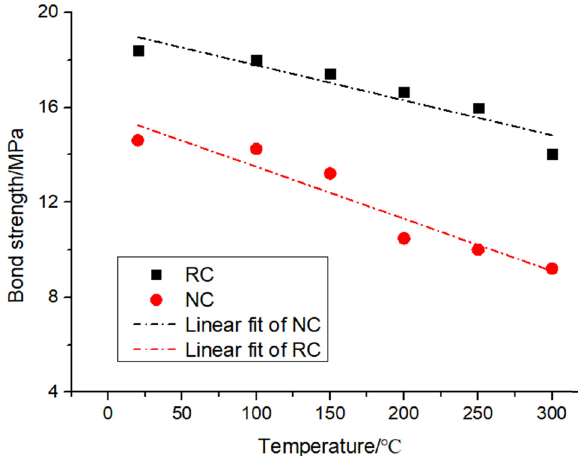
Figure 7: Linear fi tting results of bond strength.